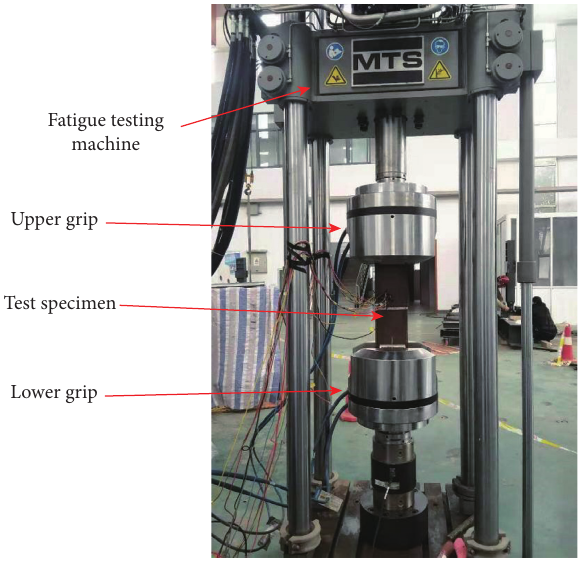
Figure 15: Fatigue test set-up. Table 3: Summary of load cases of test